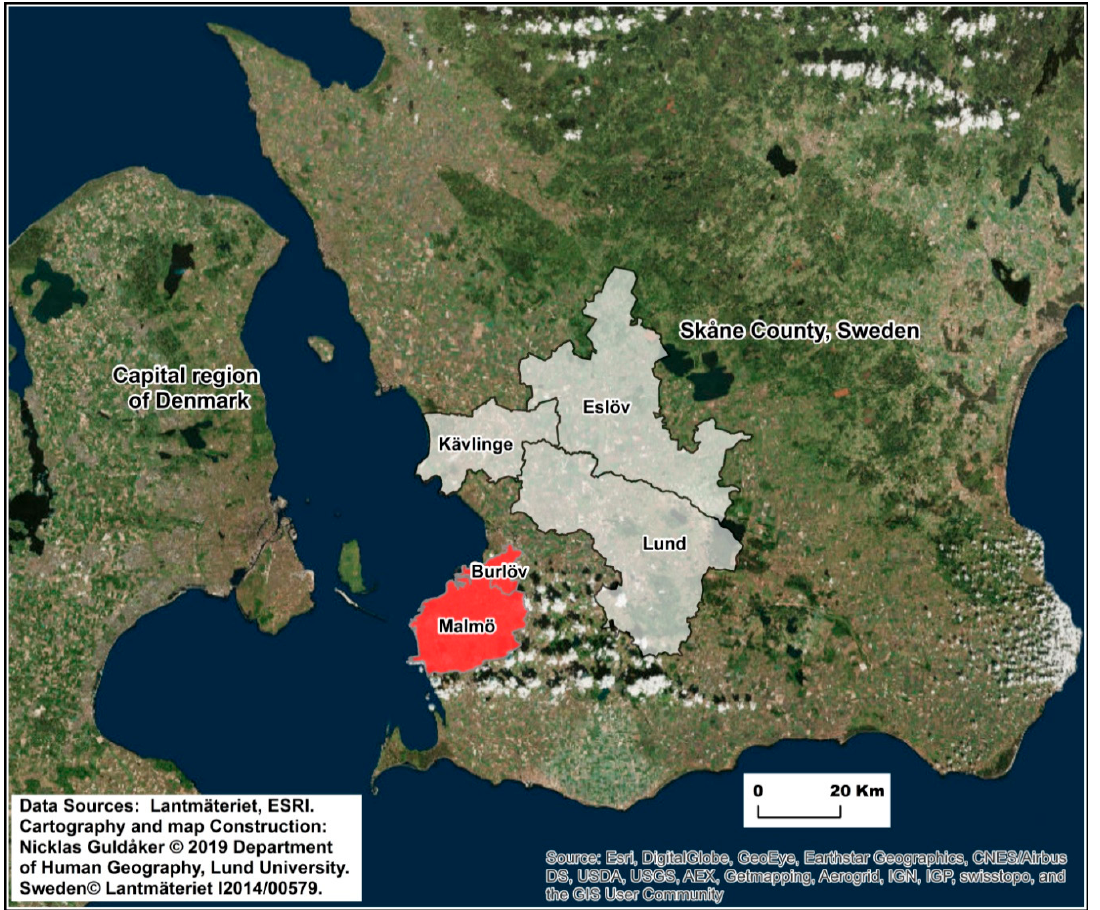
Figure 2. Emergency Services South consists of five municipalities in south Sweden, in addition to the exemplified municipalities in this study Malmö and Burlöv (in red), also Eslöv, Lund and Kävlinge.